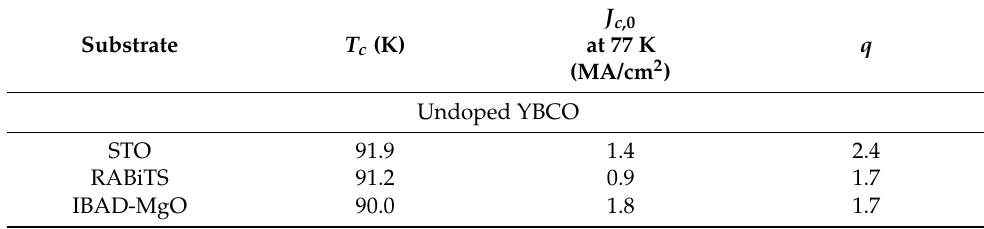
Table 3. Superconducting properties of undoped and Ag − doped YBCO films grown on different templates. T c was determined from magnetization measurements, whereas J c ,0 was determined at H = 0, and q was estimated from the fitting of the temperature dependence of J c